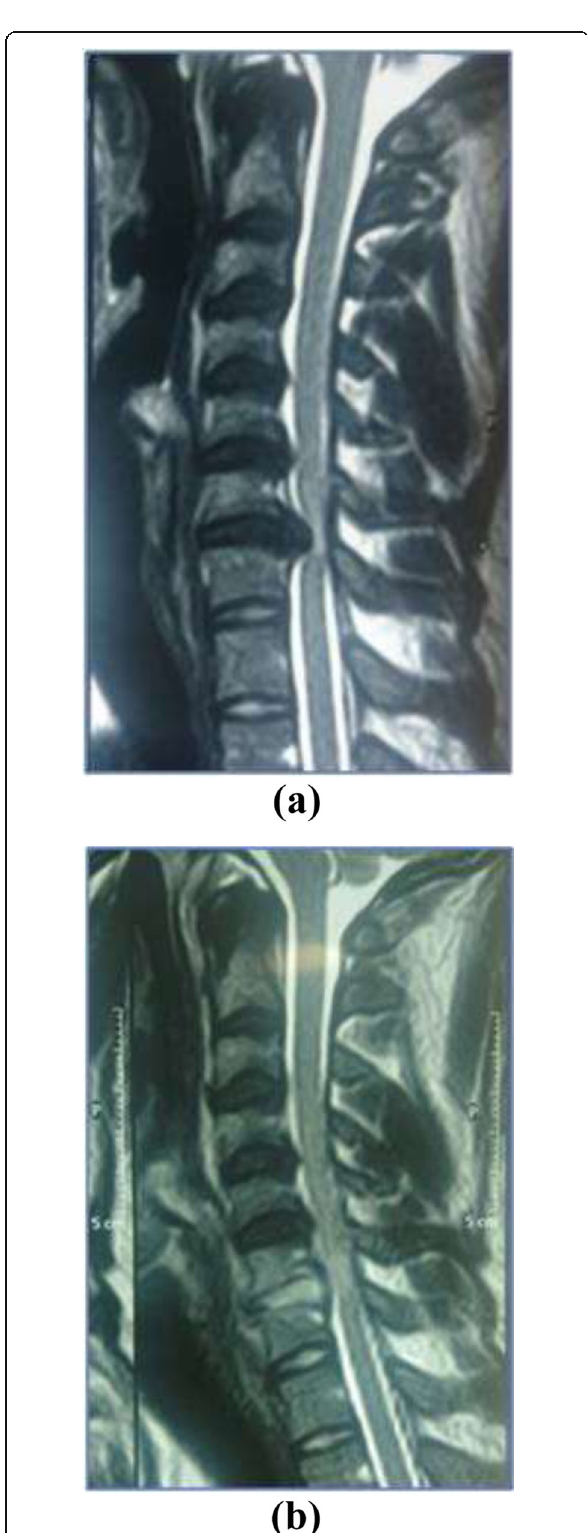
Fig. 2 a Preoperative sagittal T2-weighted MRI, showing a C6 – 7 disc prolapse. b Early postoperative sagittal T2-weighted MRI of same patient